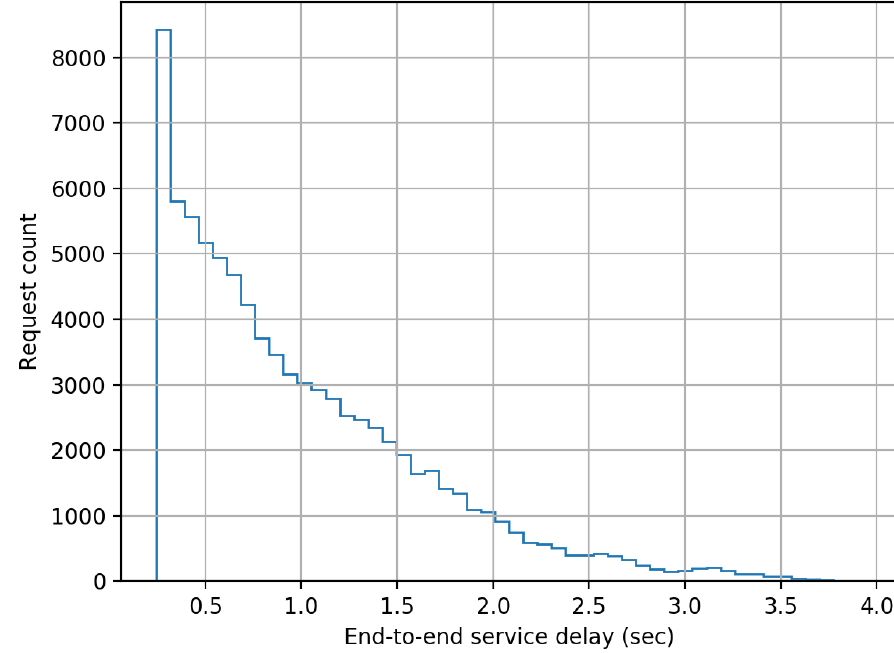
Figure 6. Distribution of end-to-end service delay at a mean request rate of 17